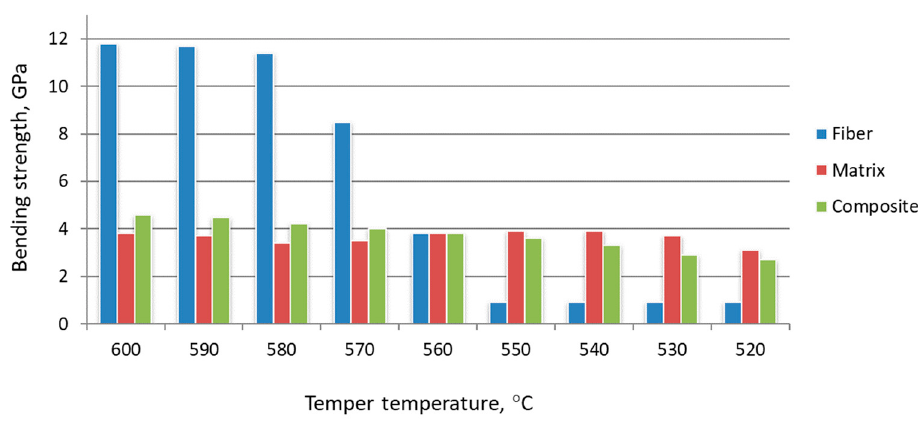
Figure 19. Effect of tempering temperature on the characteristics of composite material based on W6Mo5Cr4V2 steel, hardened at 1210 °C.